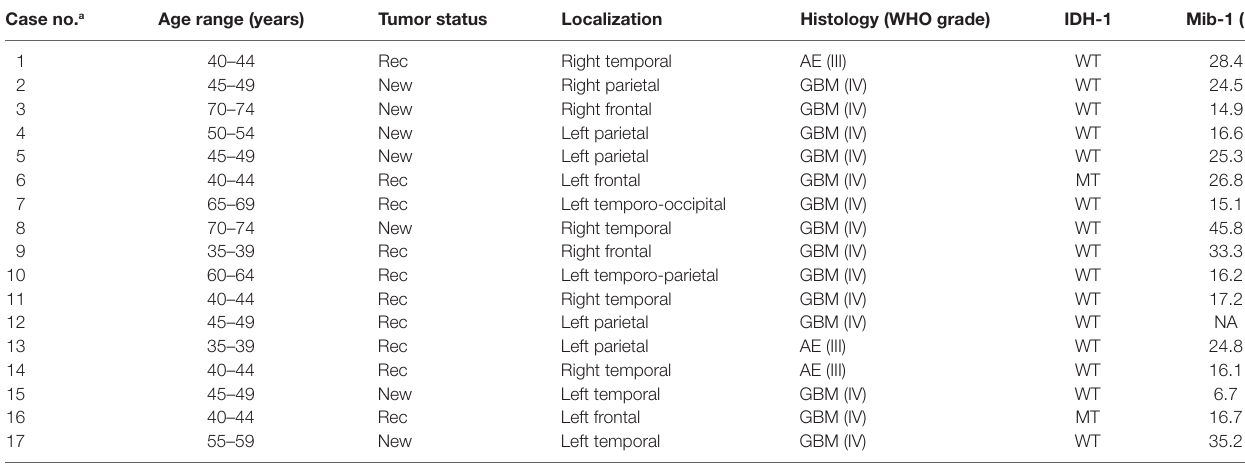
Table 1 | Characteristics of 14 patients (17